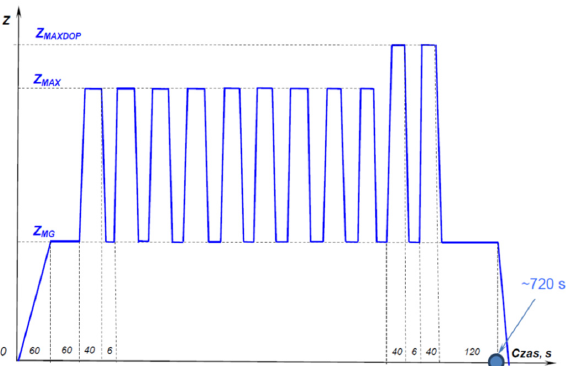
Figure 1. The realized profile of the turbojet engine research cycle. Drawing description: Z–operation range; Z MG –operation at the idle speed range (low gas); Z MAX– operation at the maximum speed range; Z MAX DOP– operation at the maximum afterburning range [18].